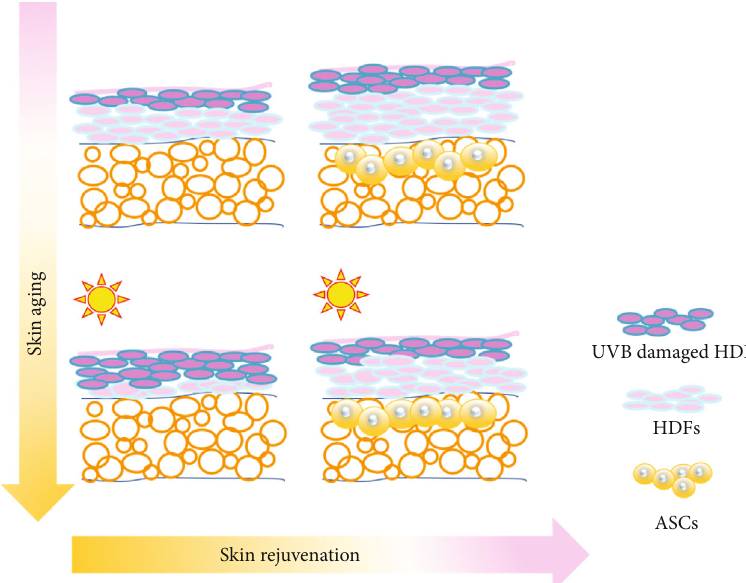
Figure 8: Schematic illustration showing the possible mechanisms by which ASCs improve aging skin through competition between UVB- damaged and undamaged